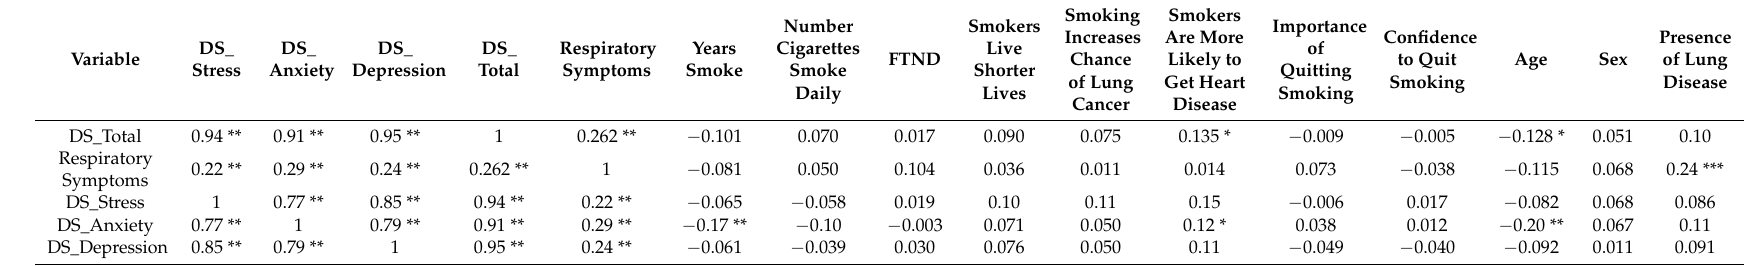
Table 3. Correlation between DASS (DS) and Respiratory Symptoms with Smoking Behaviors, Attitudes, and Social Demographics.